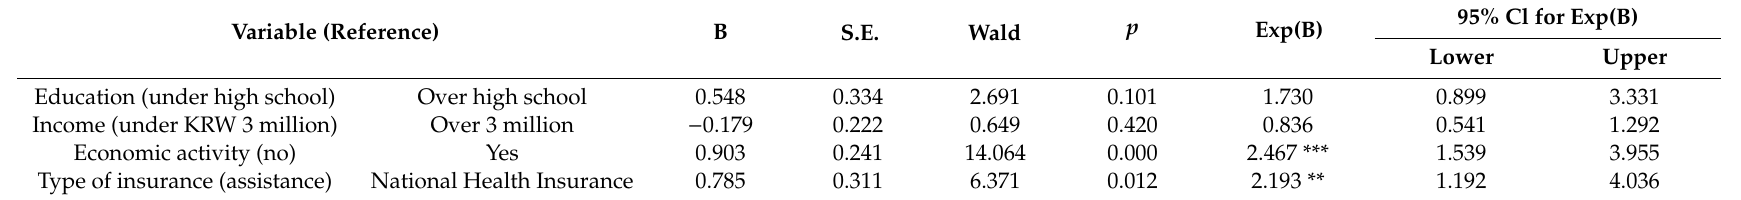
Table 2. Factors a ff ecting health-related quality of life (general